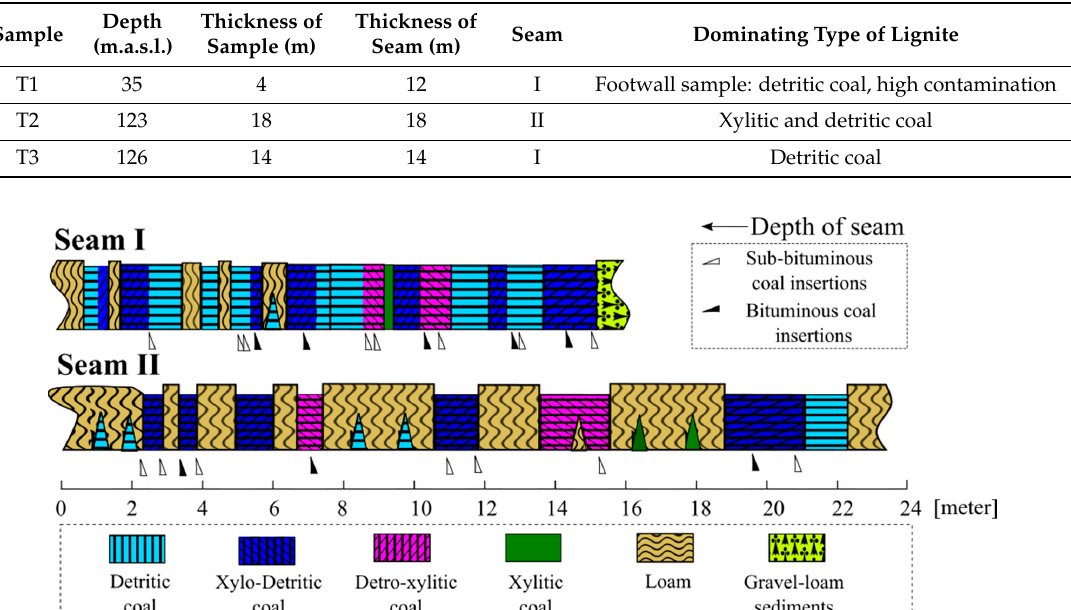
Figure 2. An exemplary of seam’s petrographic profile found in Seams I and II [22].